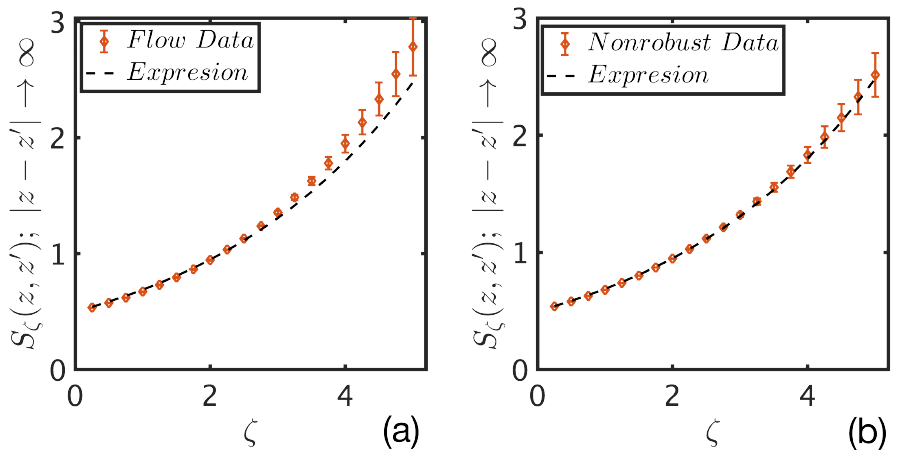
Figure 13. ( a ) The diamonds show S ζ ( z ) as a function of the moment ζ for z → ∞ for the jet flow. The dashed line is that given in Equation (12). ( b ) The corresponding comparison for the non-robust